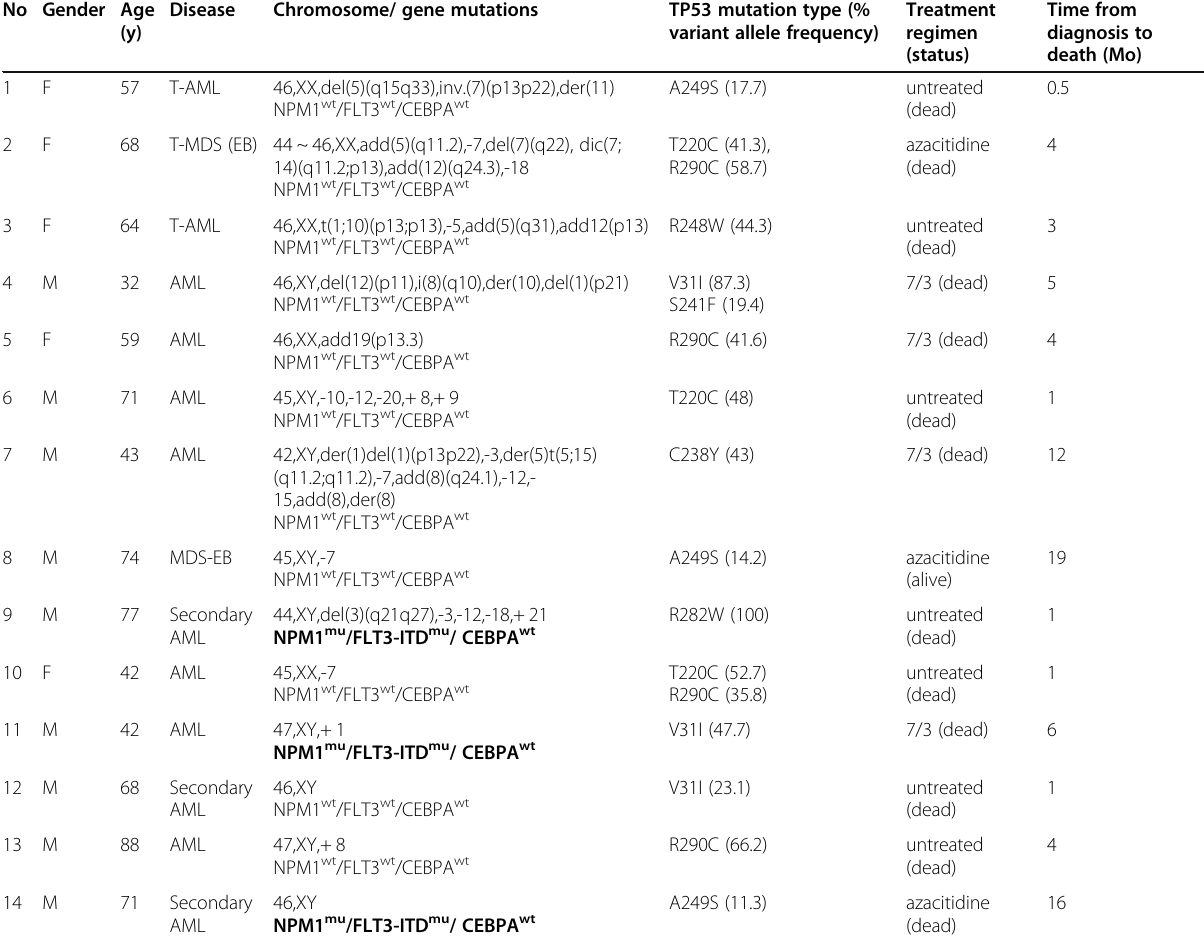
Table 2 Types of TP53 mutation and treatment outcome in 14 AML/ MDS patients No Gender Age (y)